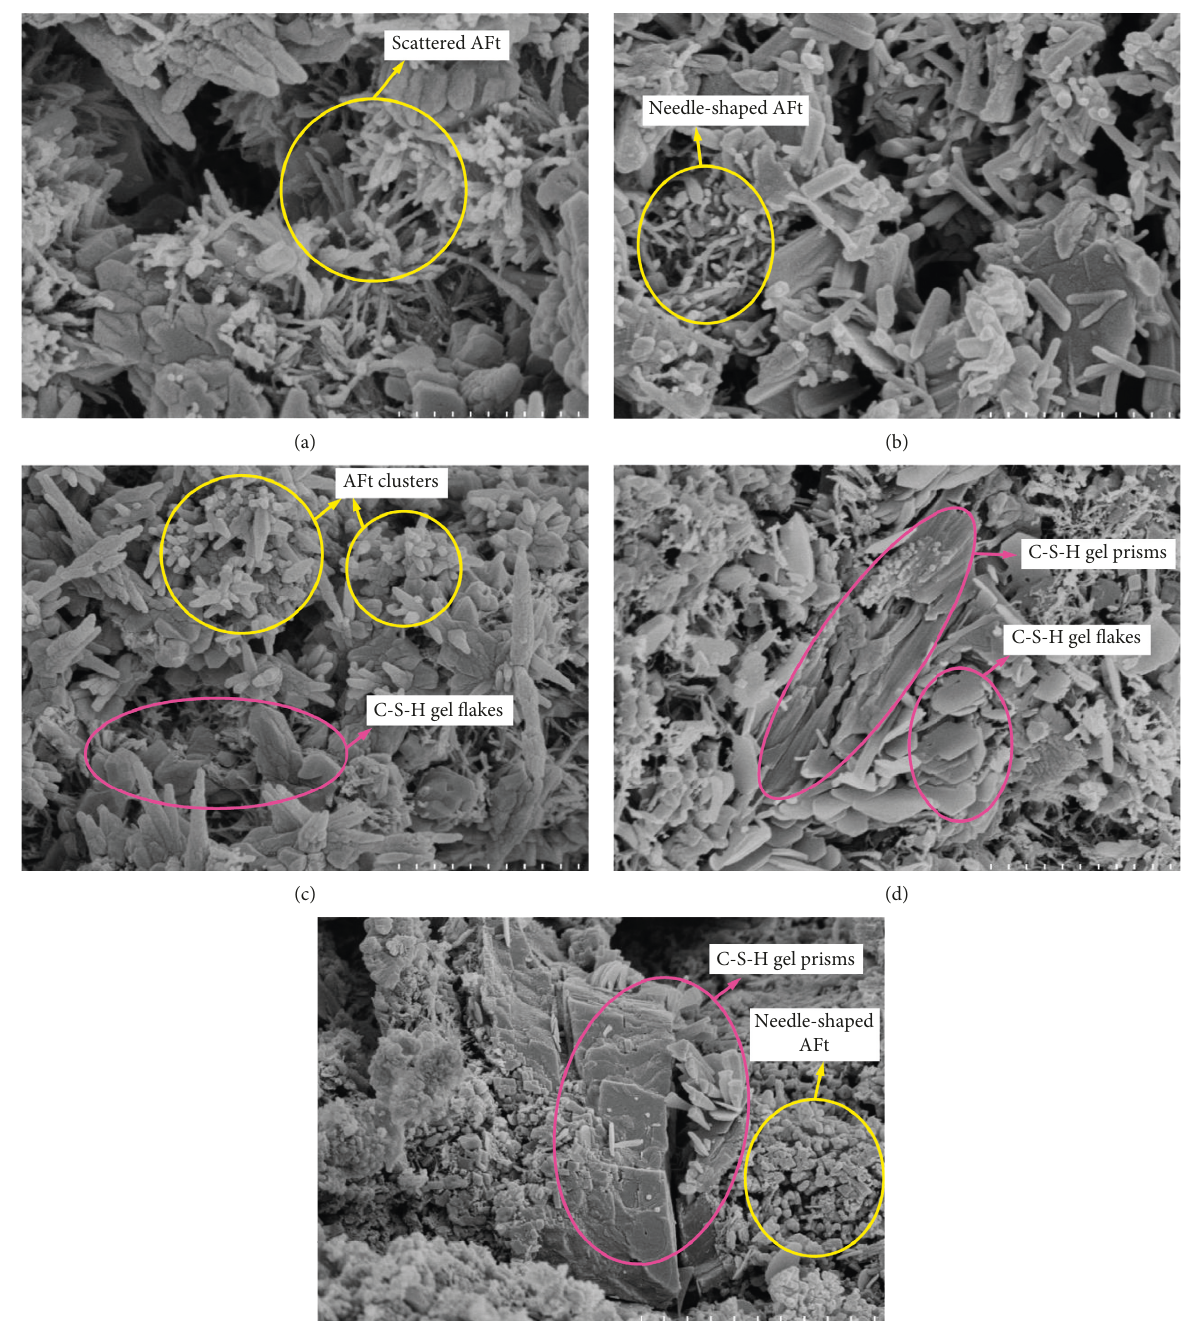
Figure 8: SEM images of samples at different ages. (a) 8 h. (b) 16 h. (c) 1d. (d) 3d. (e)